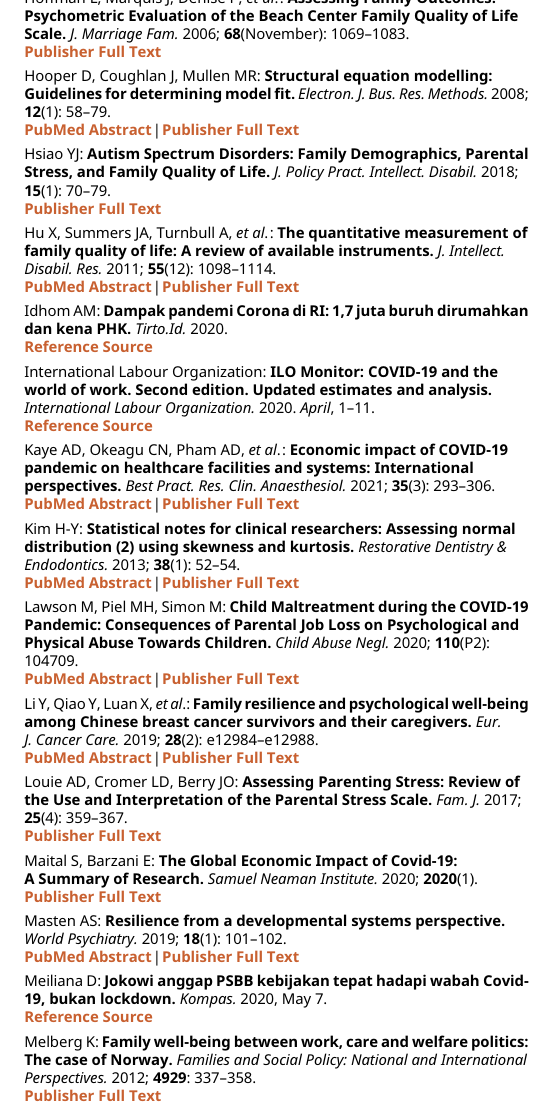
Figshare: Underlying data for “ The conditional effect of family resilience on family quality of life during the Covid-19 pandemic ” . DOI: https://doi.org/10.6084/m9.figshare.20746411 (Setiawan et al. , 2022).